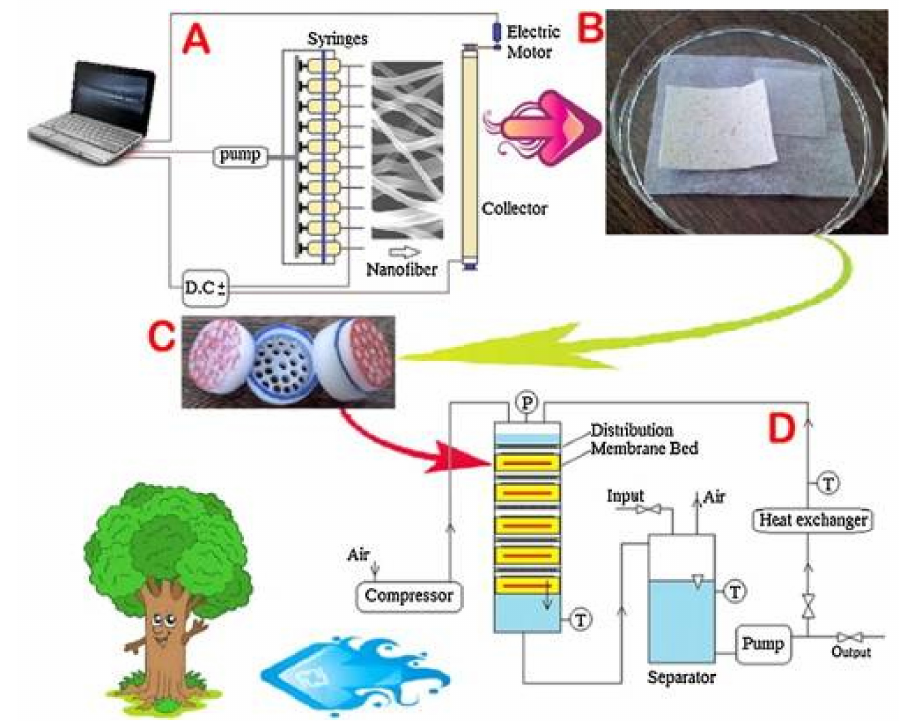
Figure 4. Schematic of the electrospinning process ( A ); nonwoven polyester web before electrospin- ning process and chitosan/PVA nanofiber membrane produced on the nonwoven polyester web after electrospinning process ( B ); membrane module ( C ); schematic of adsorption process ( D ). Reprinted with permission by [31].